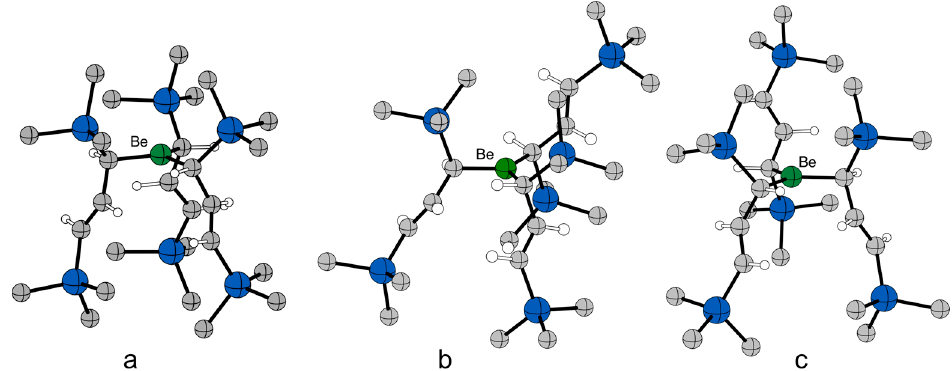
Figure 3. Geometry optimized structures of [BeA’ 3 ] − anions: ( a ) as found in the crystal structure of 1 ; ( b ) related S , S , S form with one A’ ligand rotated ( C 1 symmetry); and ( c ) R , R , S form derived from the structure of AlA’ 3 .